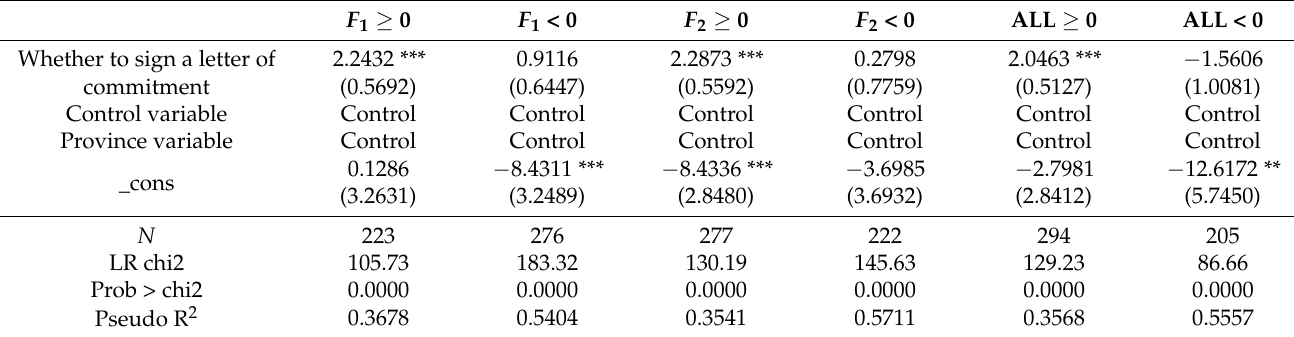
Table 7. Robustness test of the mechanism